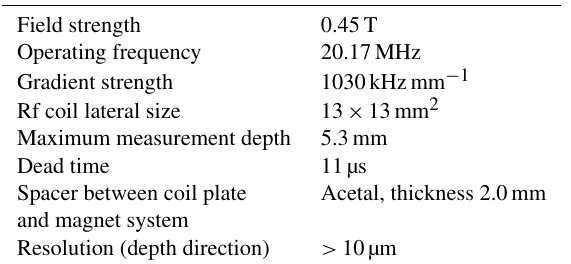
Table 1. Specifications of the used NMR-Mouse PM5 by Magritek GmbH.